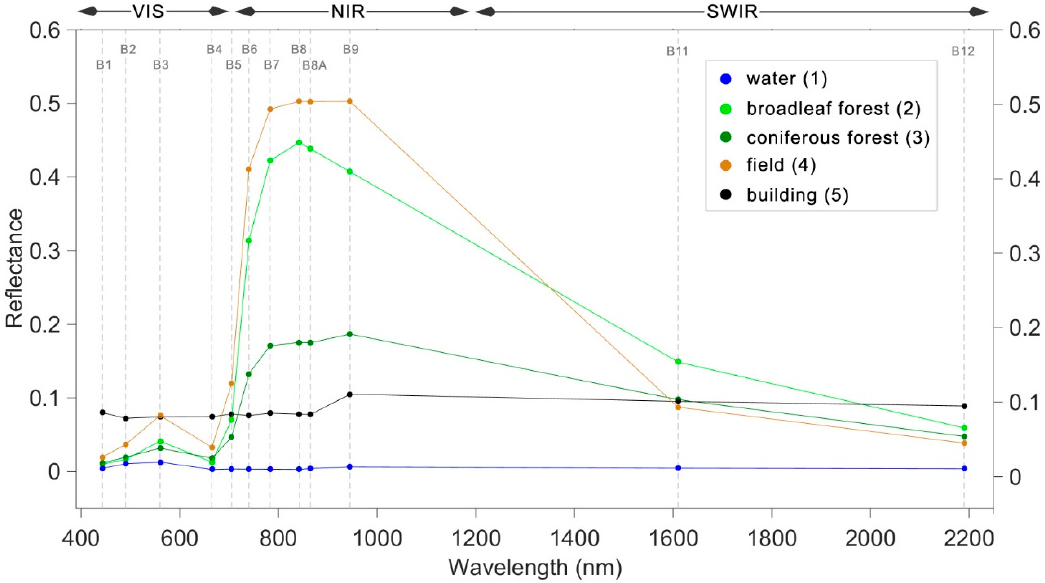
Figure 3. Spectral profiles of the points presented in Figure 2. In addition, the Sentinel-2 spectral are indicated (B1–B12) at the top of the bands are indicated (B1 – B12) at the top of the plot.